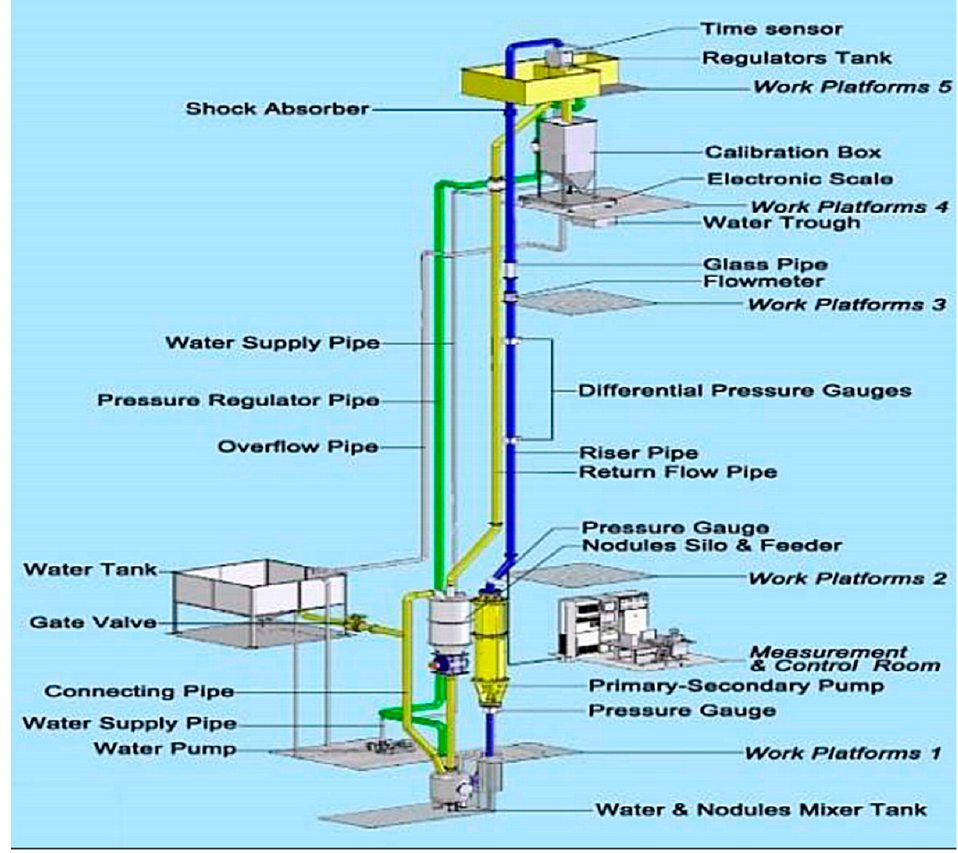
Figure 2. Schematic of the mining pump test system.